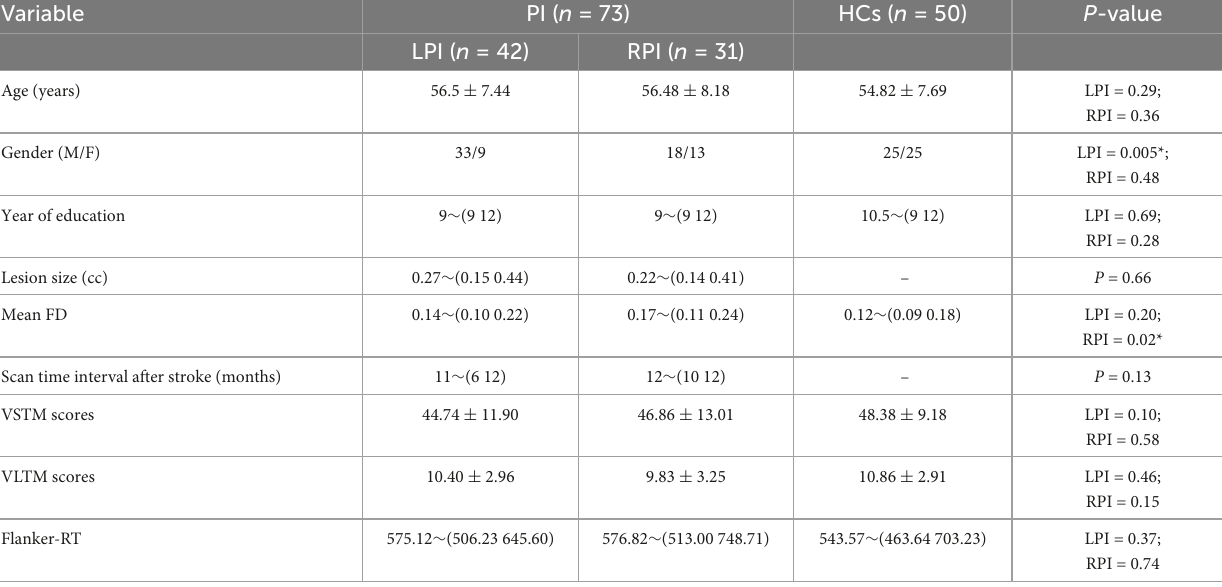
TABLE 1 Demographic and clinical data of participants.